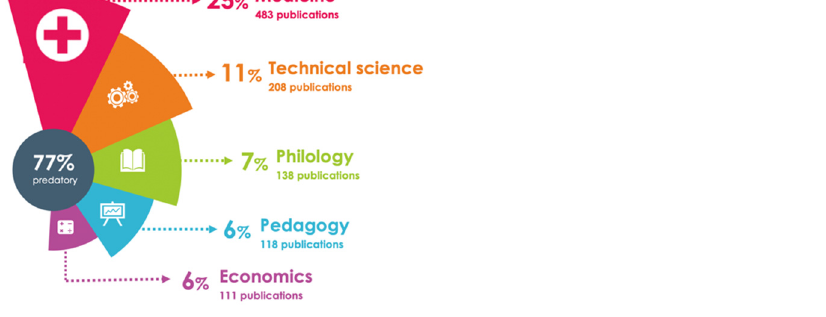
Figure 12. Top-five academic disciplines based on the number of predatory publications. Those in the medical field fall prey to predatory journals because obtaining